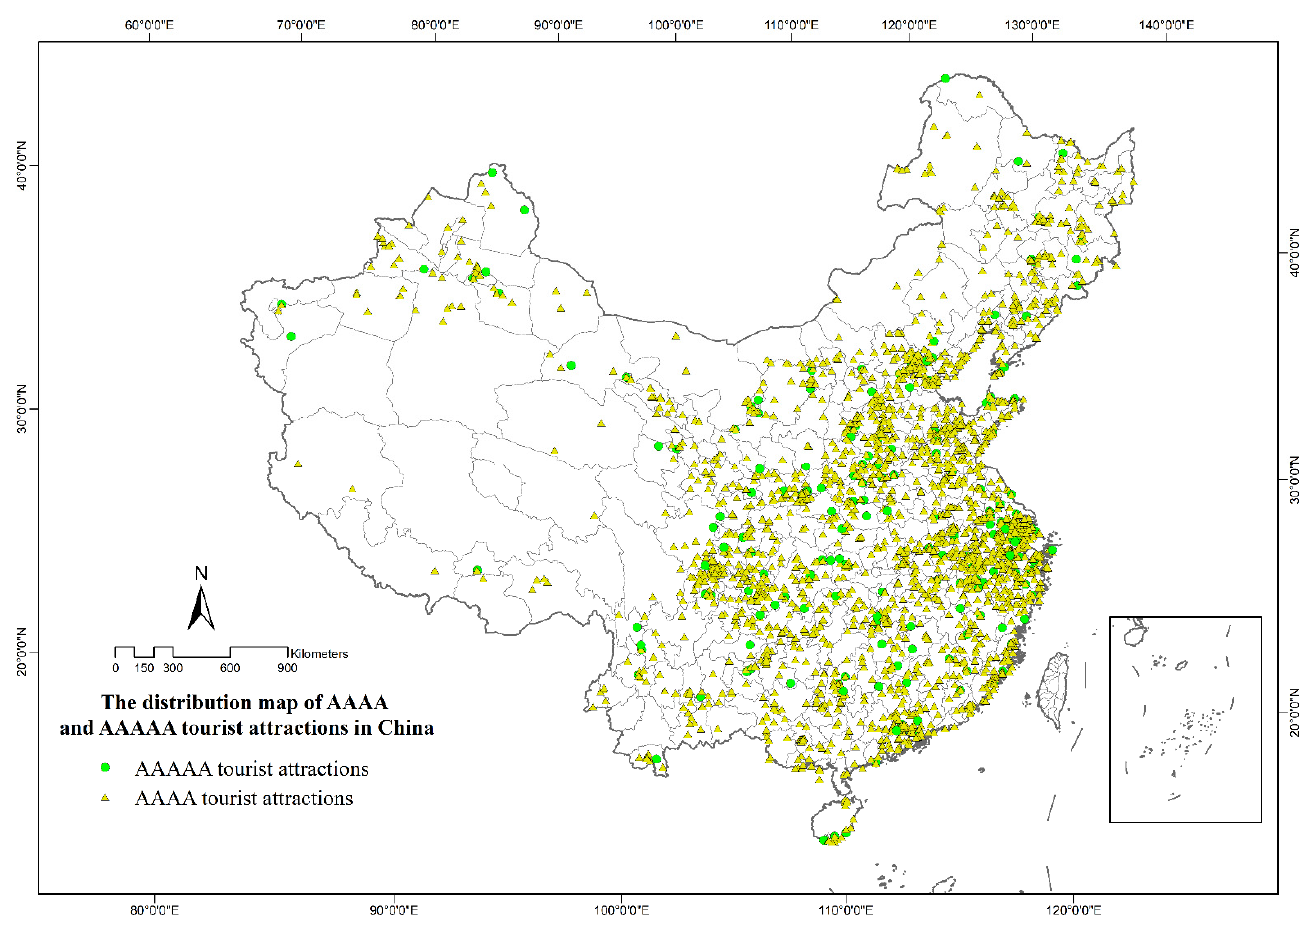
Figure 2. Sample distribution map.